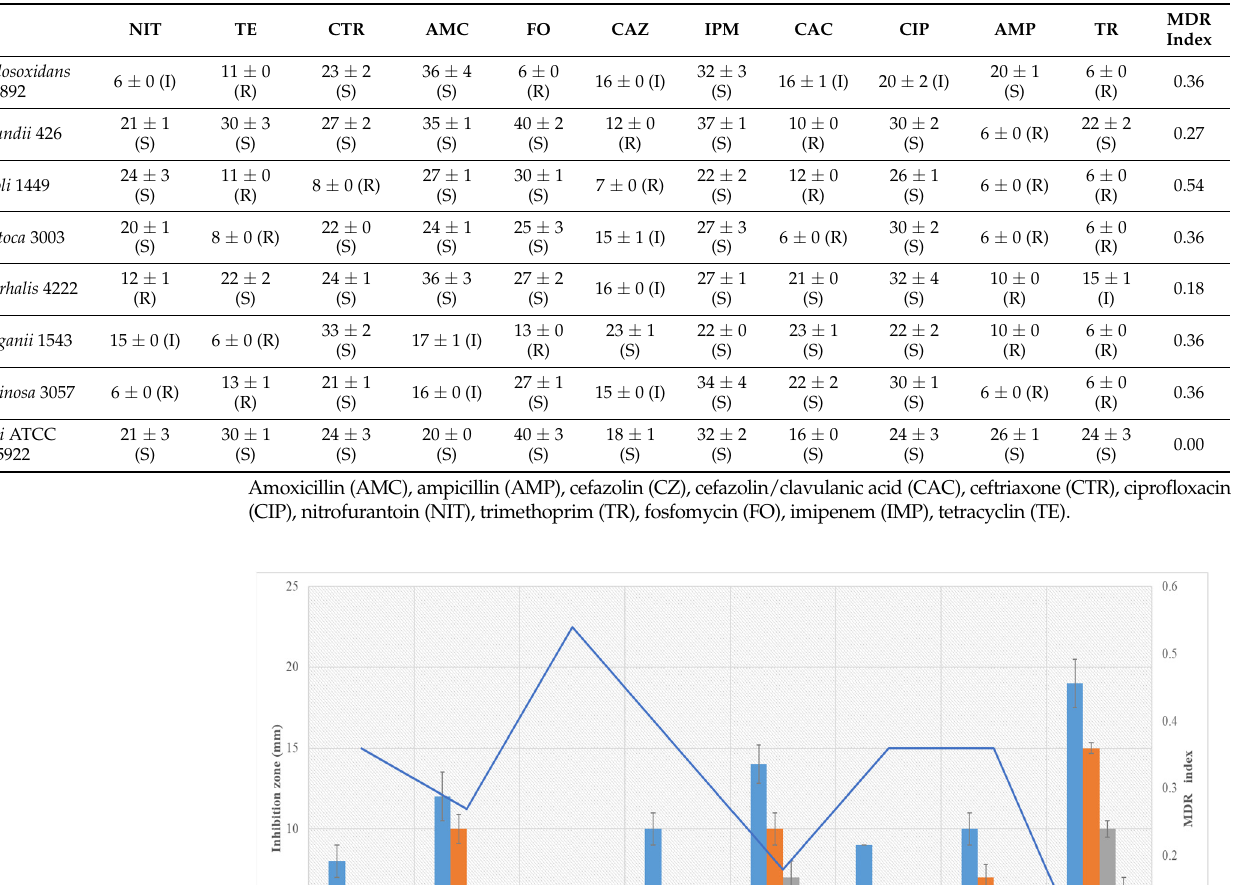
Table 3. Susceptibility to antibiotics of the test uropathogenic bacteria.